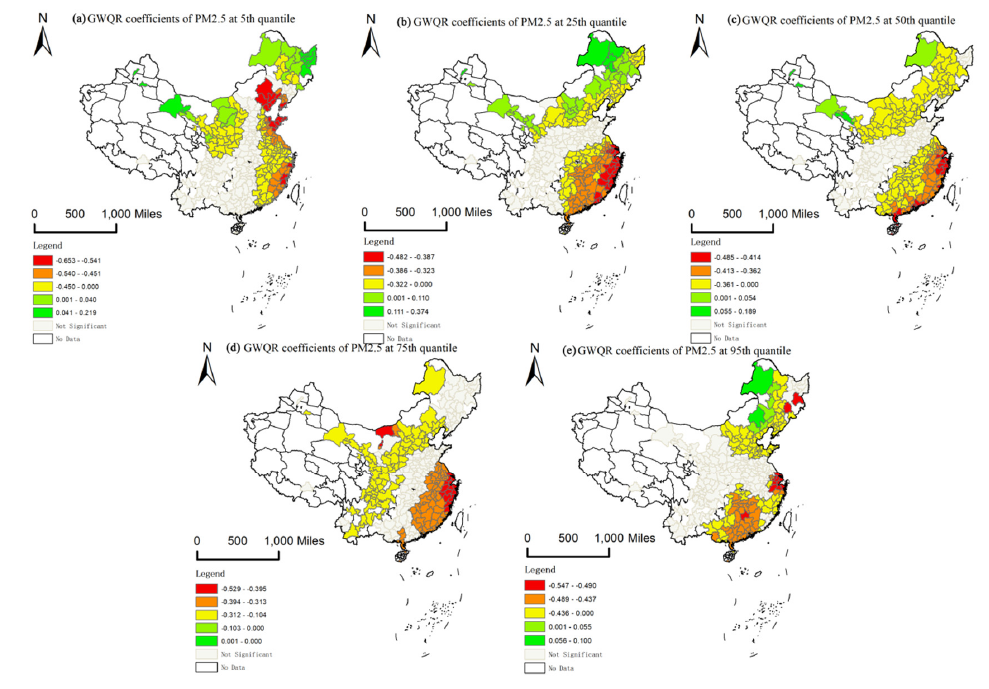
Figure A2. Spatial visualization of significant PM2.5 coefficients of GWQR for 2009. ( a )–( e ) represent the spatial distribution of significant PM2.5 coefficients for the 5th, 25th, 50th, 75th, and 95th quantiles respectively.